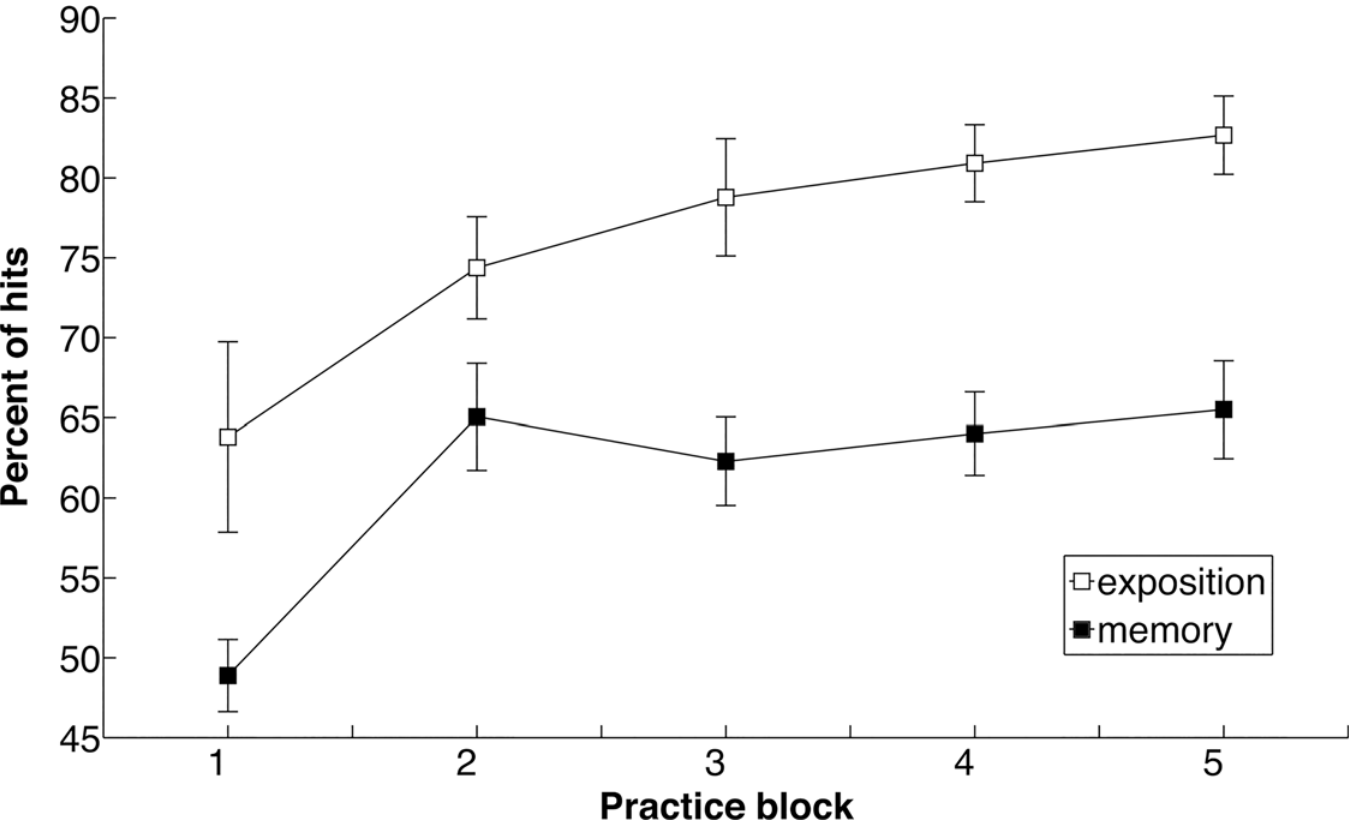
Fig 8. Reward-based performance. Percent of hits as a function of practice block at Exposition (open boxes) and at Memory (filled boxes).